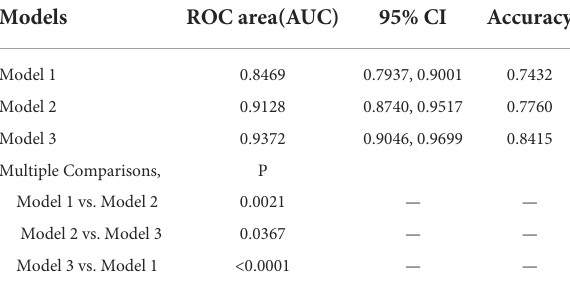
TABLE 9 Comparisons among model 1, model 2, and model